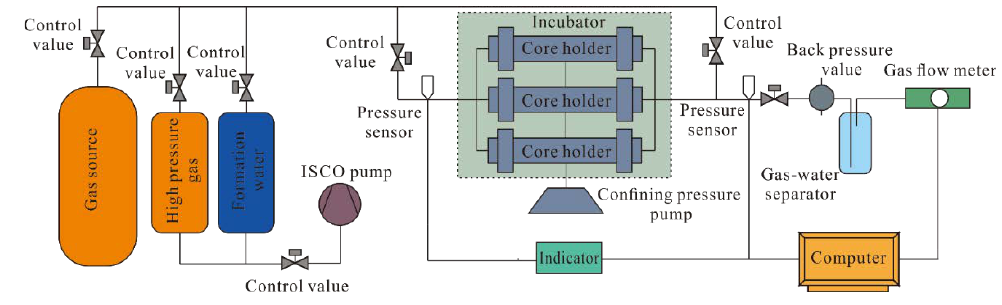
Figure 3. The experimental flow chart of the multi-core parallel experiment Table 2. The basic properties of core samples and experimental scheme.